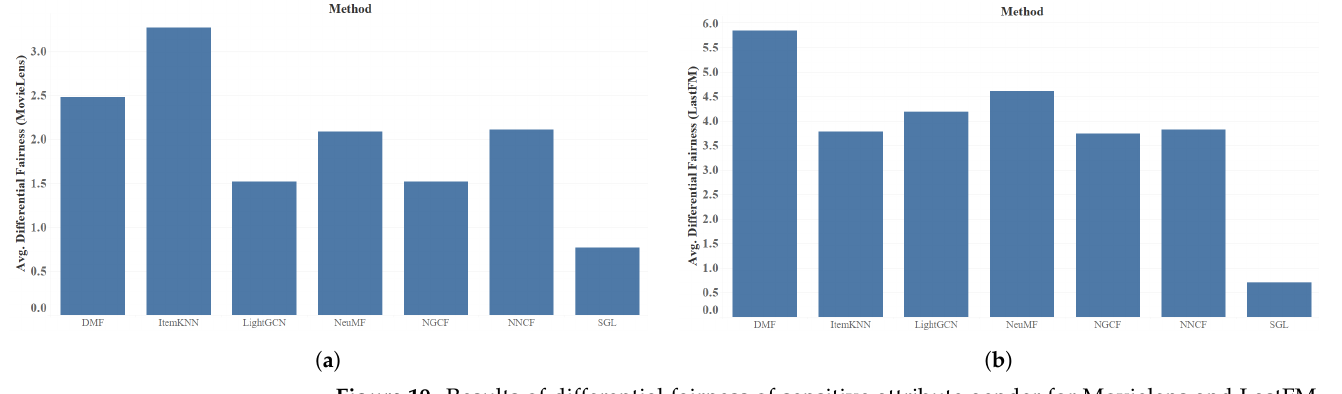
Figure 19. Results of differential fairness of sensitive attribute gender for Movielens and LastFM. ( a ) MovieLens average differential fairness of gender. ( b ) LastFM average differential fairness of